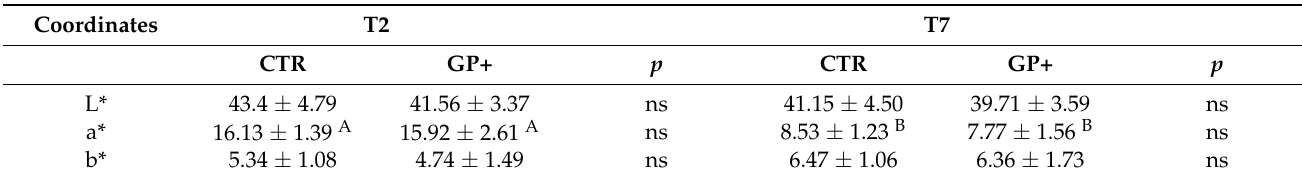
Table 3. Chromatic coordinates evaluated in raw meat collected 2 (T2) and 7 (T7) days post mortem from lambs fed with a standard diet (CTR) and lambs fed with a dietary grape pomace supplementa- tion (GP+).